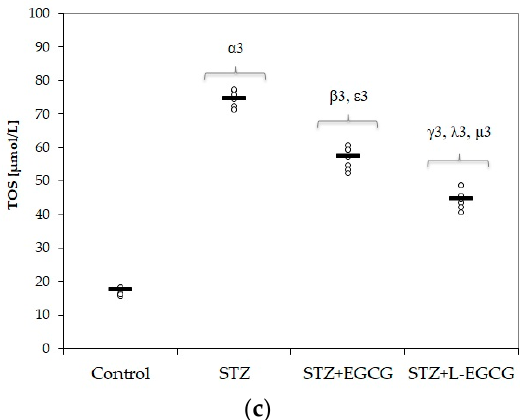
Figure 1. Distribution of oxidative stress intensity by groups: ( a ) MDA (malondialdehyde), ( b ) NOx (indirect nitric oxide), ( c ) TOS (total oxidative status) on all study groups (7 rats/group). STZ = streptozotocin control; STZ + EGCG = STZ and EGCG solution i.p. as pretreatment; STZ + L-EGCG = STZ and liposomal EGCG i.p. as pretreatment. The symbol–number codes correspond to the p -values < 0.05 as follows: α —STZ compared to control; β —STZ + EGCG compared to control; ε —STZ + EGCG compared to STZ; γ —STZ + L-EGCG compared to control; λ —STZ + L-EGCG compared to STZ; μ —STZ + L-EGCG compared to STZ + EGCG.